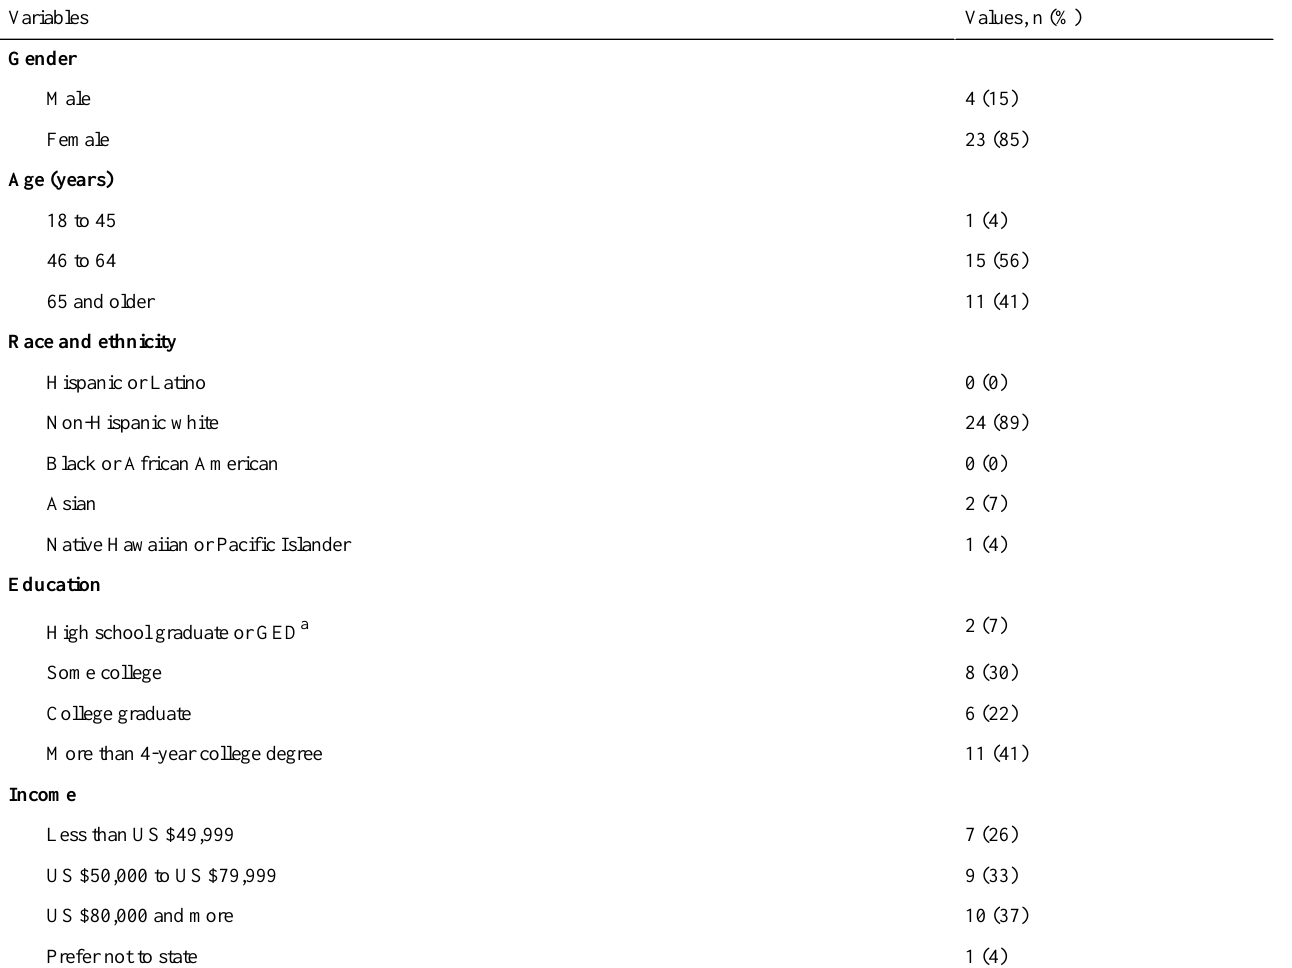
Table 1. Characteristics of interview